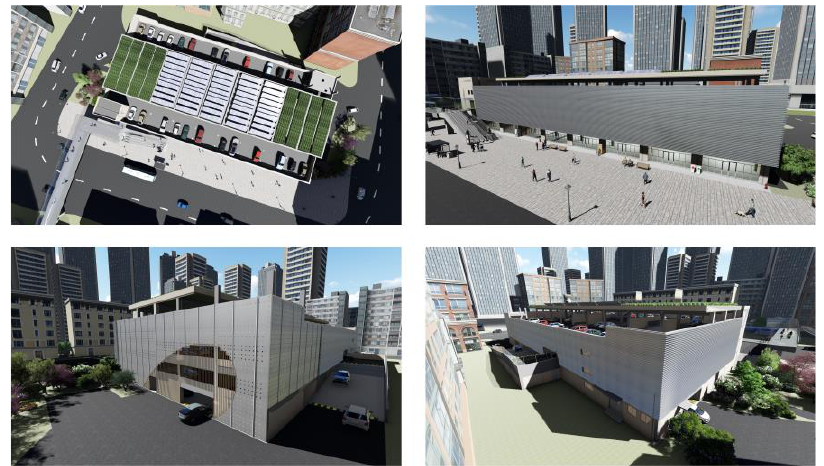
Figure 10. Exterior rendering images.